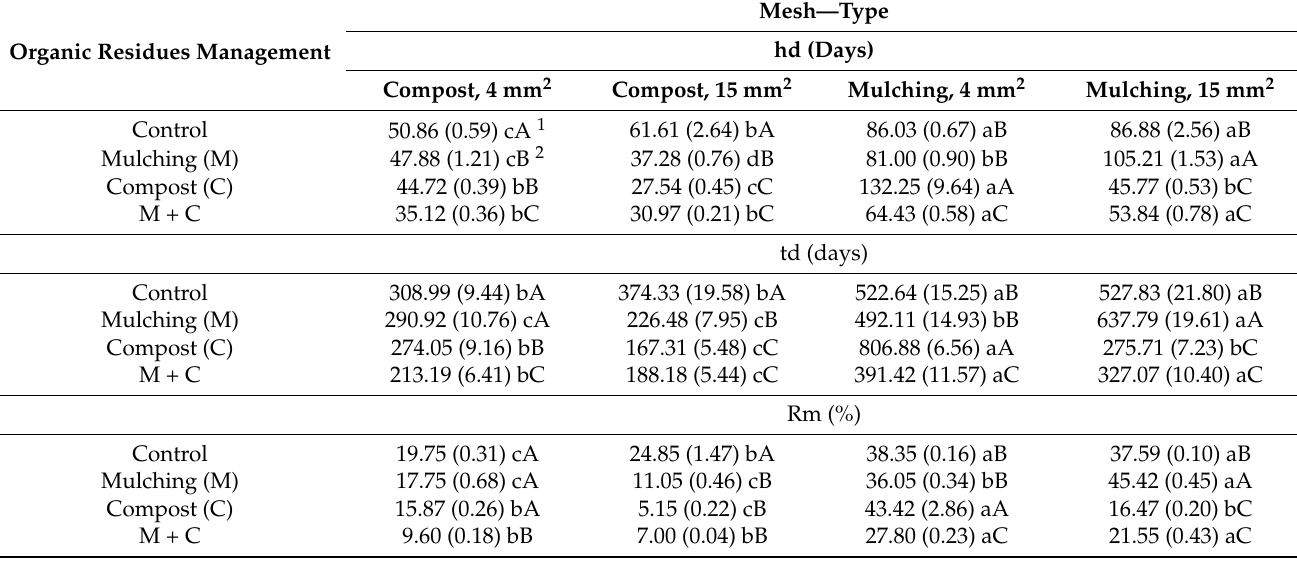
Table 3. Half-decay time (hd, days), total-decay time (td, days), and remaining litter mass (Rm, %) among the organic residues influence and litterbag mesh-type in a subtropical ecosystem, Curitibanos, SC, Southern